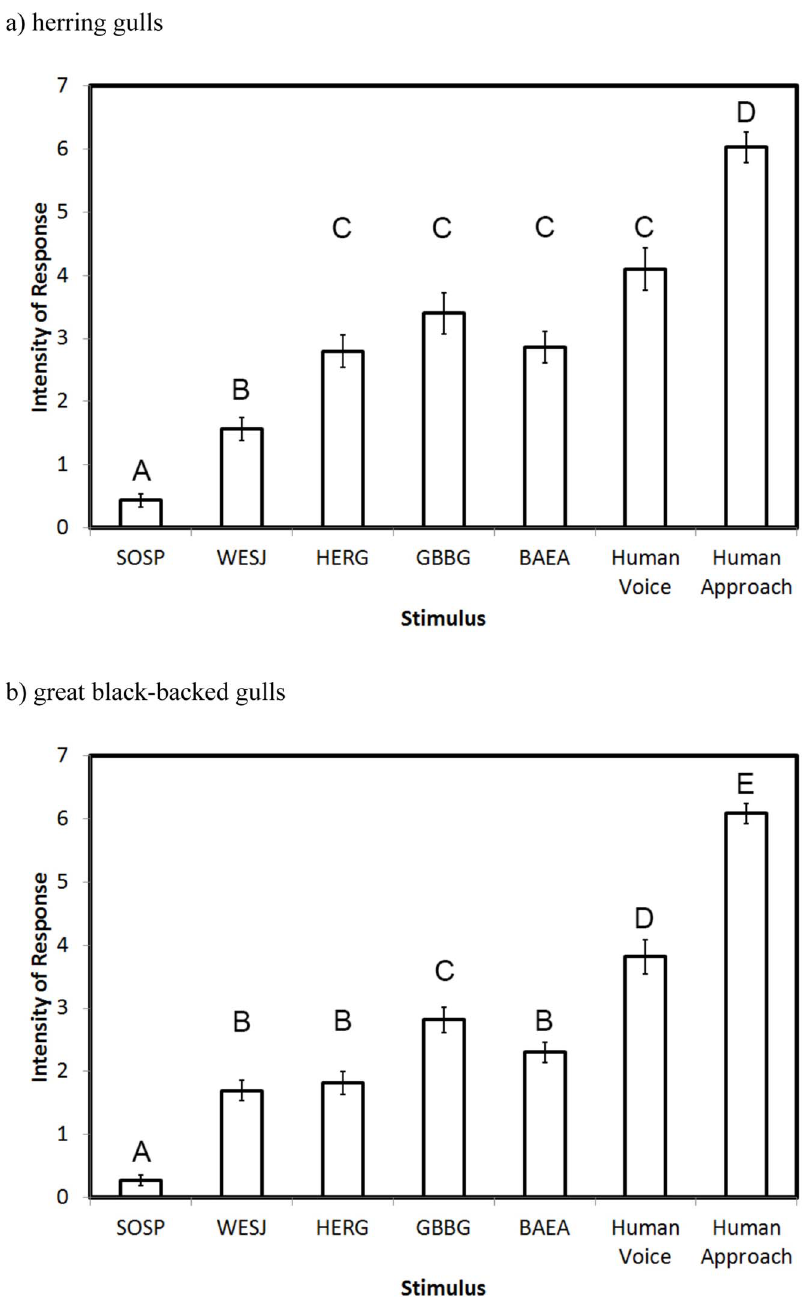
Figure 1. Intensity of response to auditory threats. Intensity of response by (a) herring gulls and (b) great black-backed gulls to various auditory stimuli and a physical approach by a human. Raw means and standard errors are reported, with different letters indicating statistically significant differences among stimuli, based on log odds ratios. SOSP = song sparrow, WESJ = western scrub-jay, HERG = herring gull, GBBG = great black-backed gull, BAEA = bald